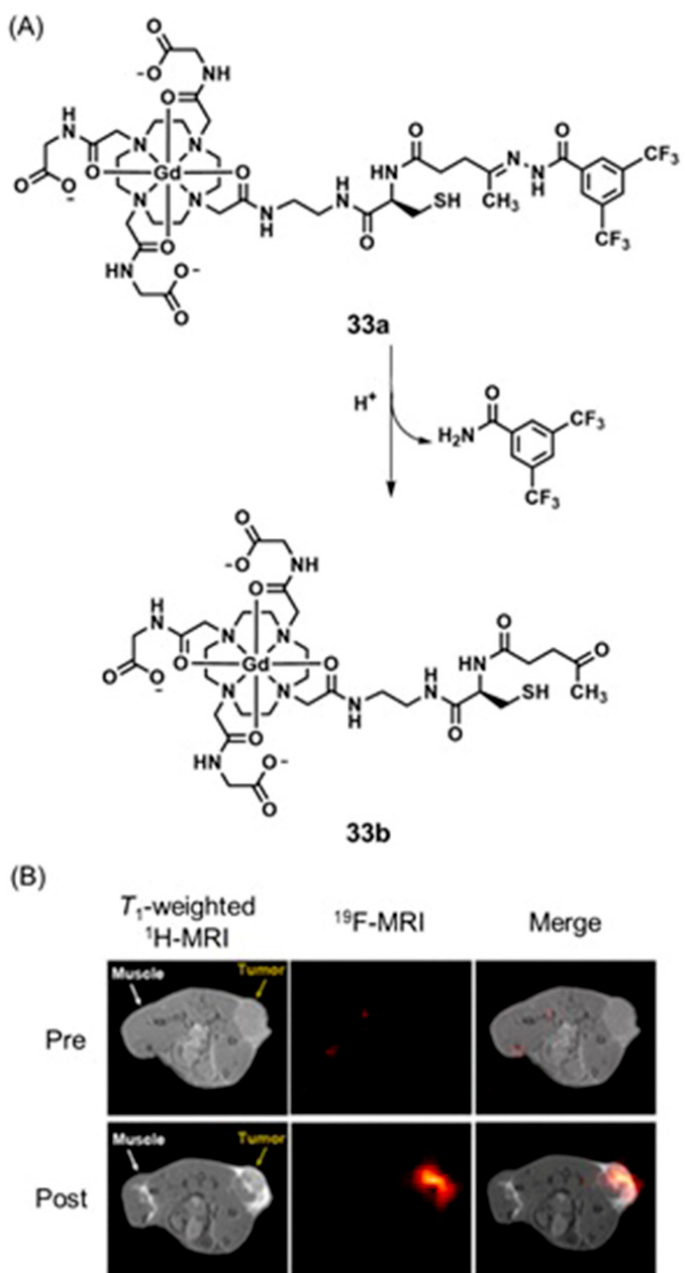
Figure 67. ( A ) Chemical reaction behind the 19 F signal recovery of 33a in response to mildly acidic tumor microenvironment. ( B ) T 1 -weighted 1 H-MRI and 19 F-MRI of tumor-bearing mice before and after administration of fluorinated gadolinium chelate-grafted palladium nanoconjugates at 9.4 T. Yellow and white arrows indicate the tumor and muscle, respectively. Adapted with permission